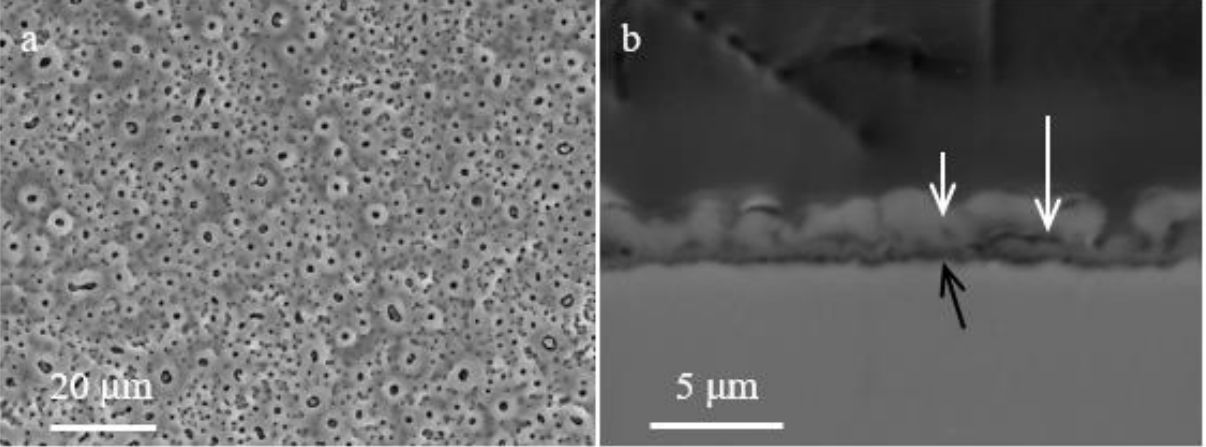
Figure 7. ( a , b ): SEM of the M-PEO specimen surface and cross-section, respectively. White and black arrows indicate porosity remarks discussed in the text. Table 3. Porosity values obtained by image analysis for the flash-PEO coatings on the EB-structured samples. * G1-PEO-R1 and 2013R2 correspond to image analysis in regions marked in Figure 9a. Specimen